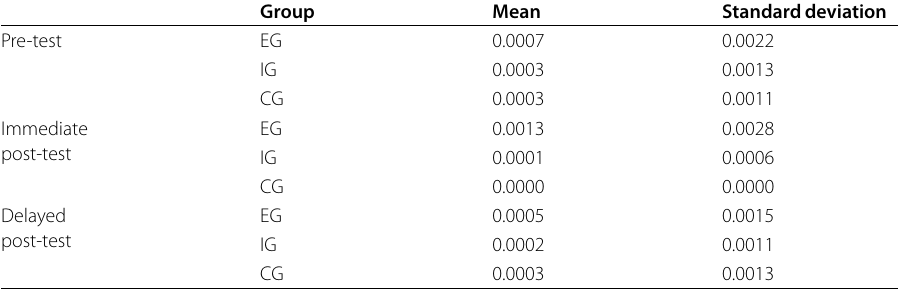
Table 3 Descriptive statistics for appeals to shared knowledge (normalized values) Group Mean Standard deviation